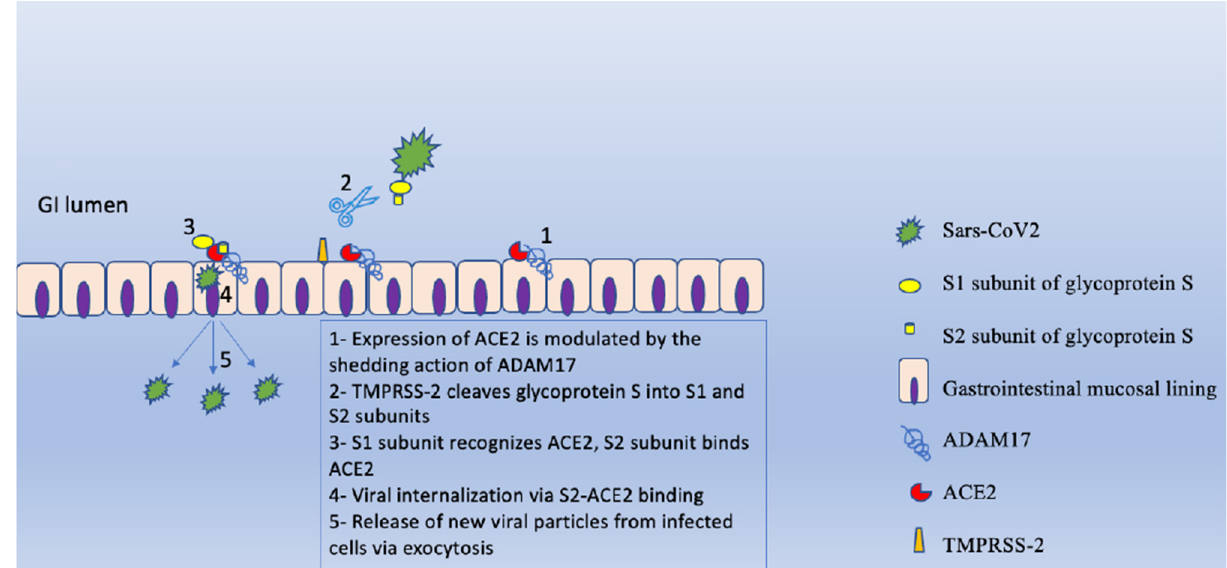
Figure 1. Illustration of the role of ADAM metallopeptidase domain 17 (ADAM17) and transmembrane protease, serine 2 (TMPRSS-2) in SARS-CoV-2 infection, adapted to the GI mucosal lining.